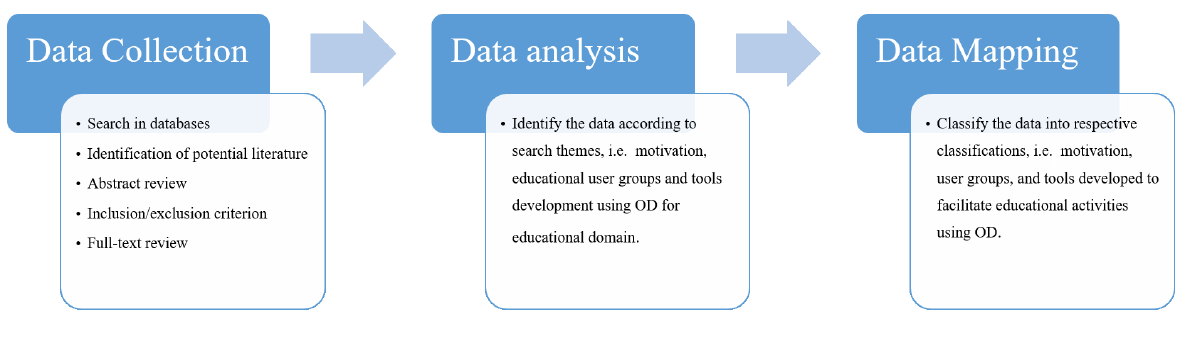
Figure 1. Overview of systematic mapping review method inspired by [19]; OD – Open Data